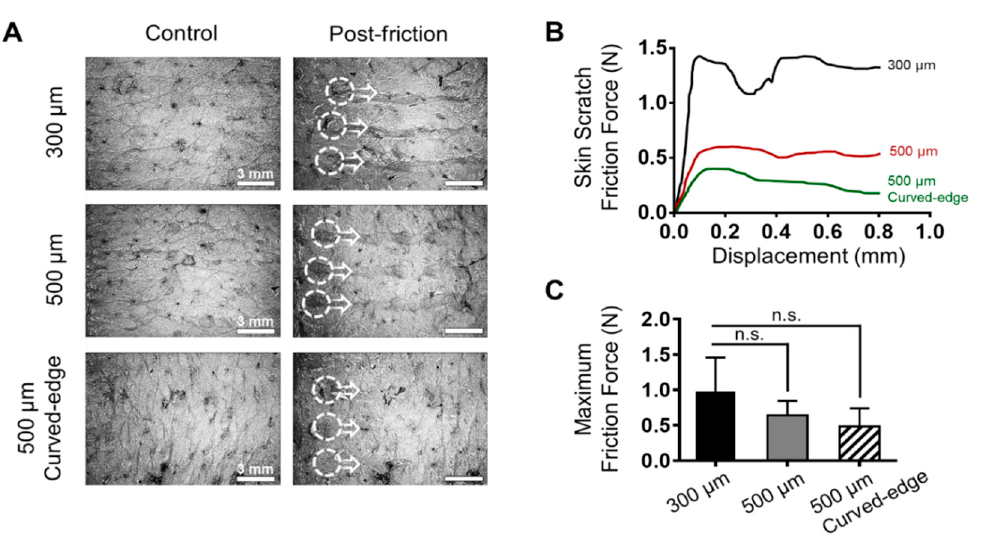
Figure 4. Evaluation of skin damage caused during the separation process of DMNs from micropillars. ( A ) Trace of micropillars over the skin surface upon application of the lateral force. The 300 µ m micropillars caused considerable damage to the skin, whereas this was remarkably less in both 500 µ m and curved-edge 500 µ m micropillars. ( B ) Skin scratch friction force changes against displacement. The friction force of the 300 µ m micropillars was higher than that of the other micropillars. ( C ) The maximum friction force of the micropillars against skin. Although 300 µ m micropillars showed a higher friction force, due to sti ff ness properties of the skin, the data were not significant. Both 500 µ m and curved-edge 500 µ m micropillars had similar friction forces. Scale bars in ( A ) are 3 mm. Data in ( B , C ) are expressed as mean ± S.D.